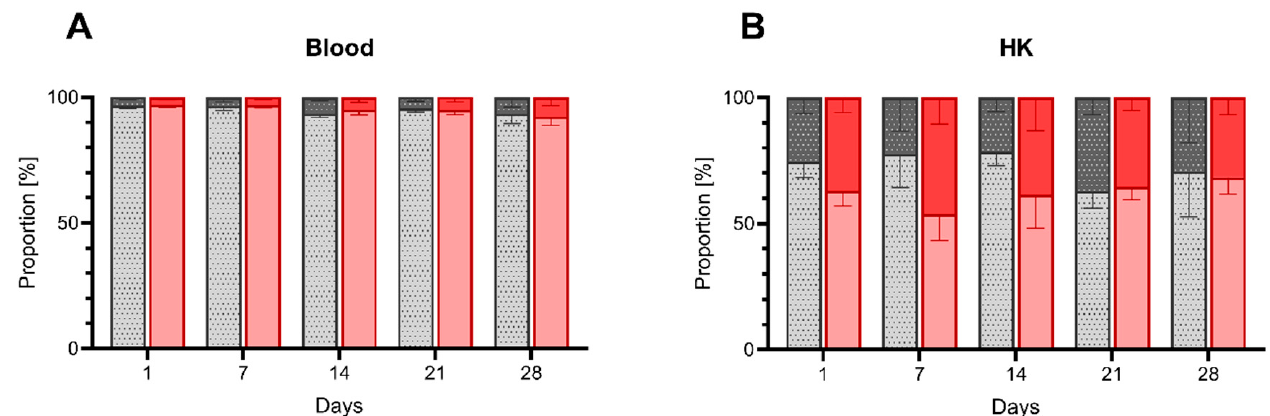
Figure 2. Proportion of myeloid and lymphoid cells within blood and HK of pikeperch challenged with low DO conditions. Proportion (%) of lymphoid (bright color) and myeloid cells (dark color) in collected blood ( A ) and head kidney (HK; ( B )) samples of pikeperch. HK was additionally purified by Percoll-gradient. Columns represent mean of five individual samples (+SEM) from control (grey/patterned) and hypoxia group (red) after one, seven, fourteen, twenty-one and twenty-eight days of the experiments. Statistical significance per cell type per each day was determined using the multiple t-test (Holm–Šídák corrected), with alpha = 0.05.